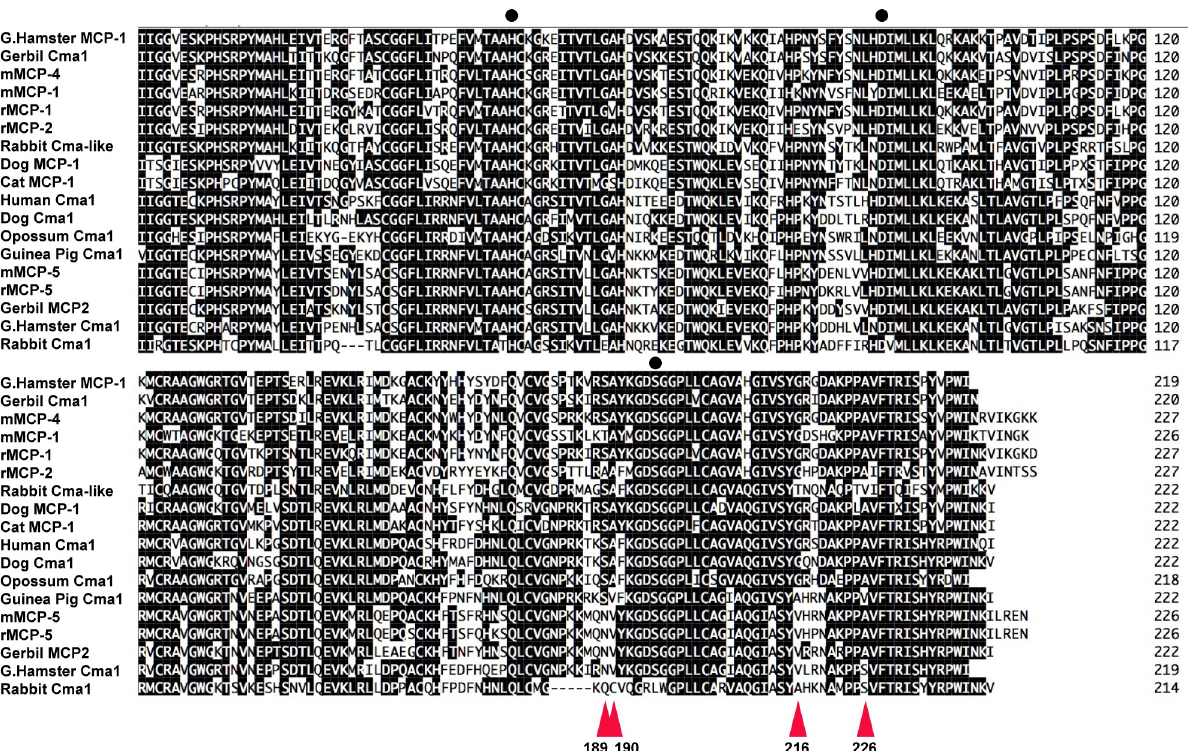
Fig 10. Alignment of a number of mammalian alpha and beta chymases. A panel of mammalian alpha and beta chymases were aligned using the DNA Star Megalign program and using the Clustal W algorithm. The positions of the three residues of the catalytic triad His-Asp-Ser are marked by black dots. The positions of the four amino acids of the substrate pocket, residues 189, 190, 216 and 226, are marked by red arrows. These four residues are for many of these proteases (at least the mammalian enzymes) of major importance for their P1 selectivity [5, 6, 15, 16].